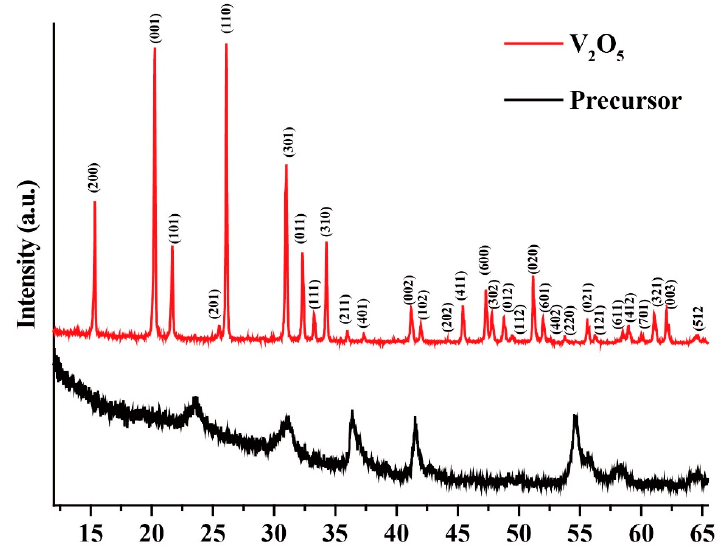
Figure 1. The XRD patterns of nanosized V 2 O 5 and precursor before calcination.